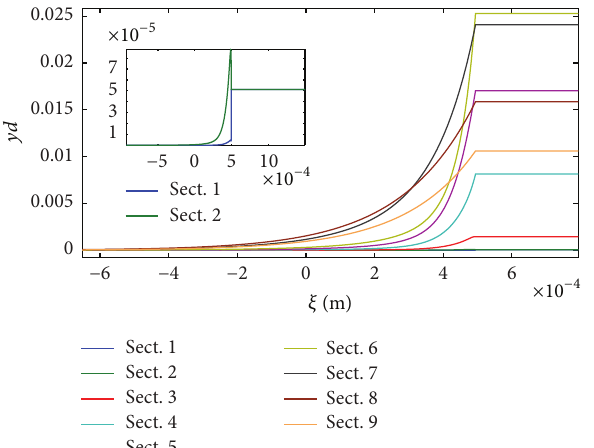
Figure 10: Liquid fuel sectional mass fractions profiles in one- dimensional laminar spray flame propagation; initial size distribu- tion 3.